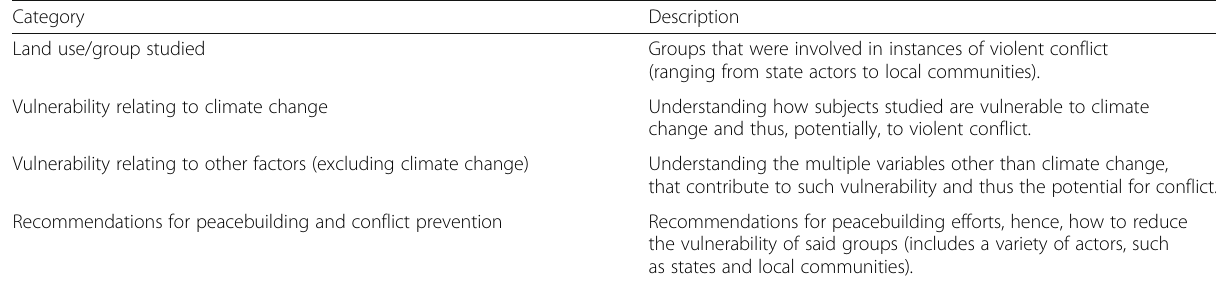
Table 5 Classification of articles into four selected categories for the climate-conflict nexus Category